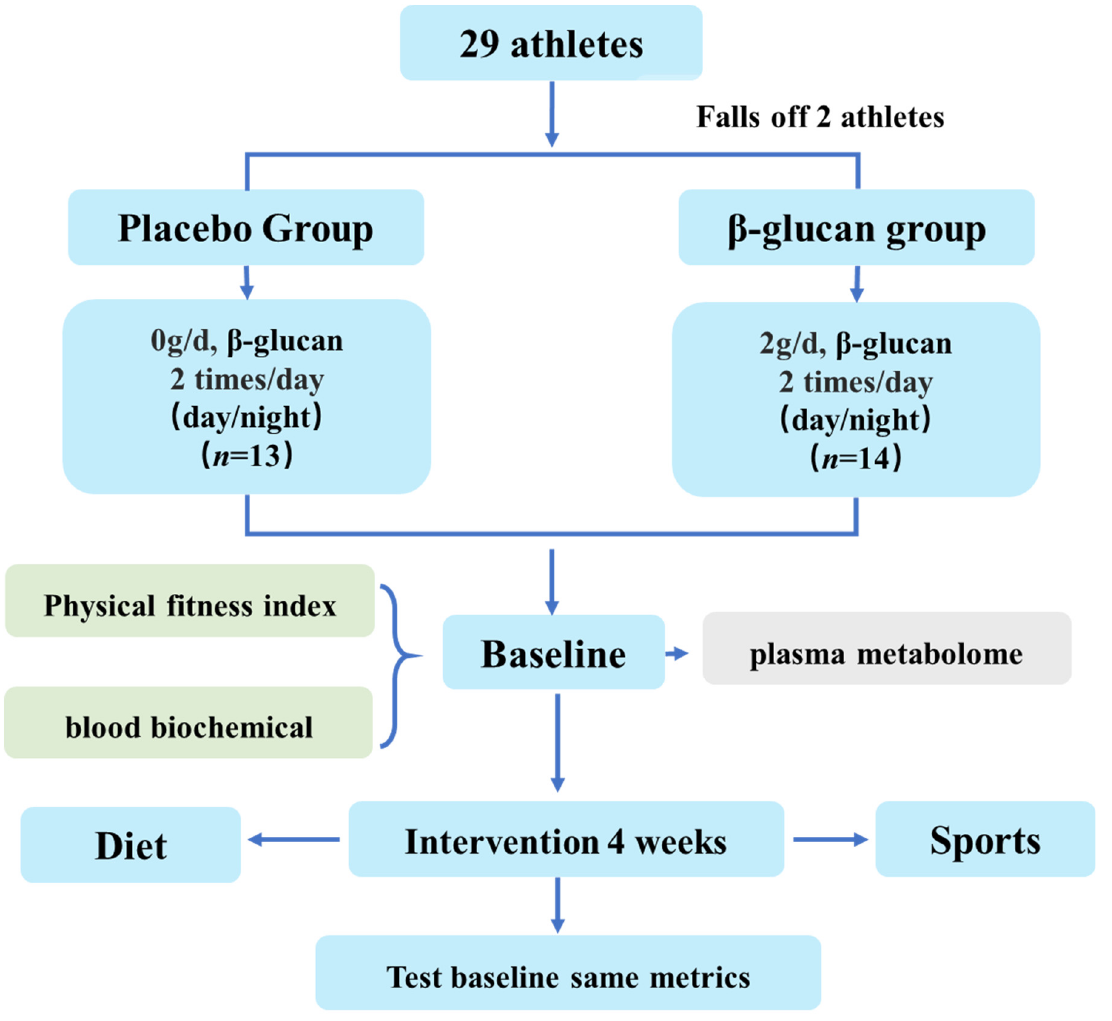
Figure 1. The trial flow.